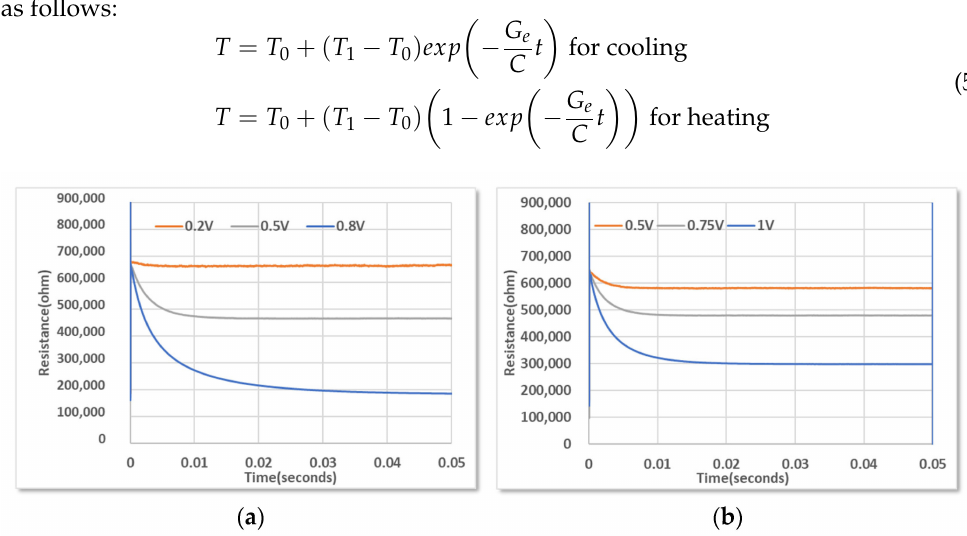
Figure 9. Resistance change with time at ( a ) 20 mTorr and ( b ) 100 mTorr under pulsed bias condition (pulse width: 30 µ